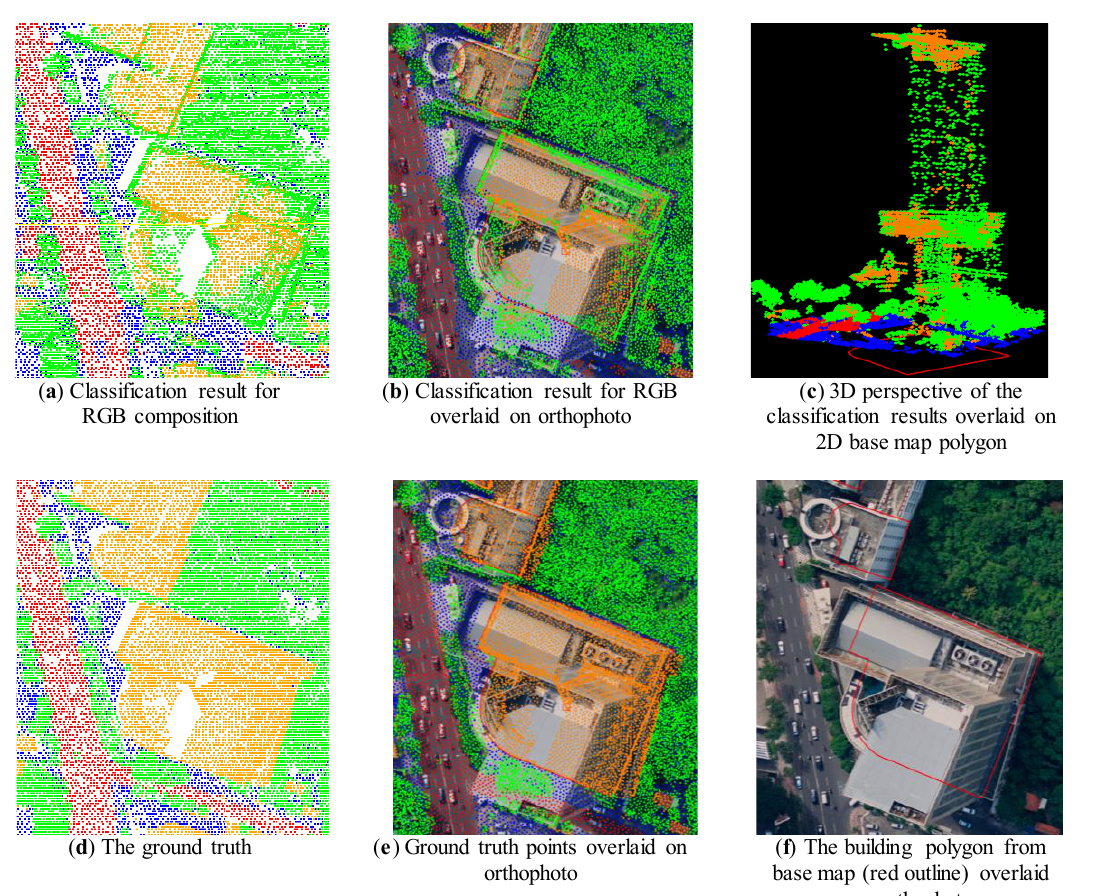
Figure 7. Results in an area where relief displacement occurs. The classification method still correctly predicts ground and tree points that may have incorrect spectral